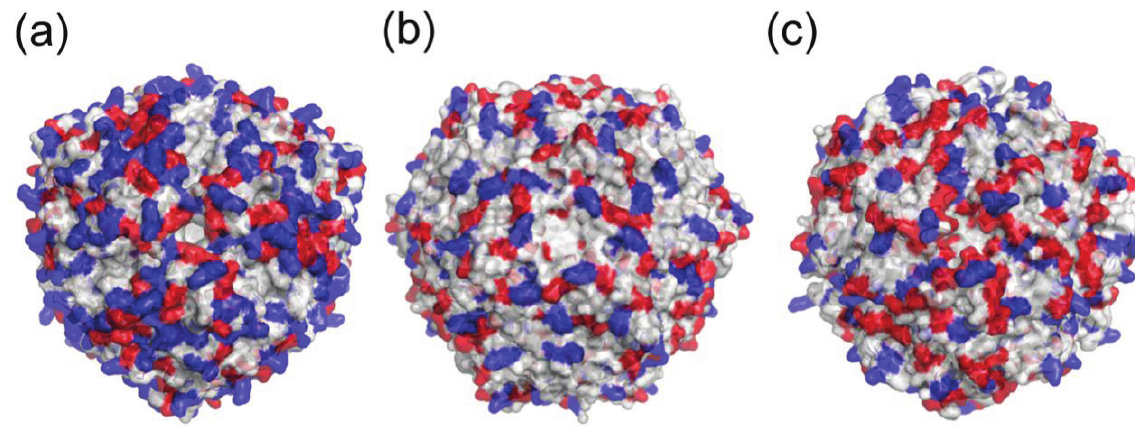
Figure 7. Molecular surface respresentations of HP-NAP and Dps proteins. Negatively charged residues (Asp and Glu) are colored red and positively charged residues (Lys, Arg, and His) blue. ( a ) The Fe-loaded HP-NAP YS39 dodecamer; ( b ) E. coli Dps dodecamer (PDB ID: 1DPS); ( c ) L. innocua ferritin dodecamer (PDB ID: